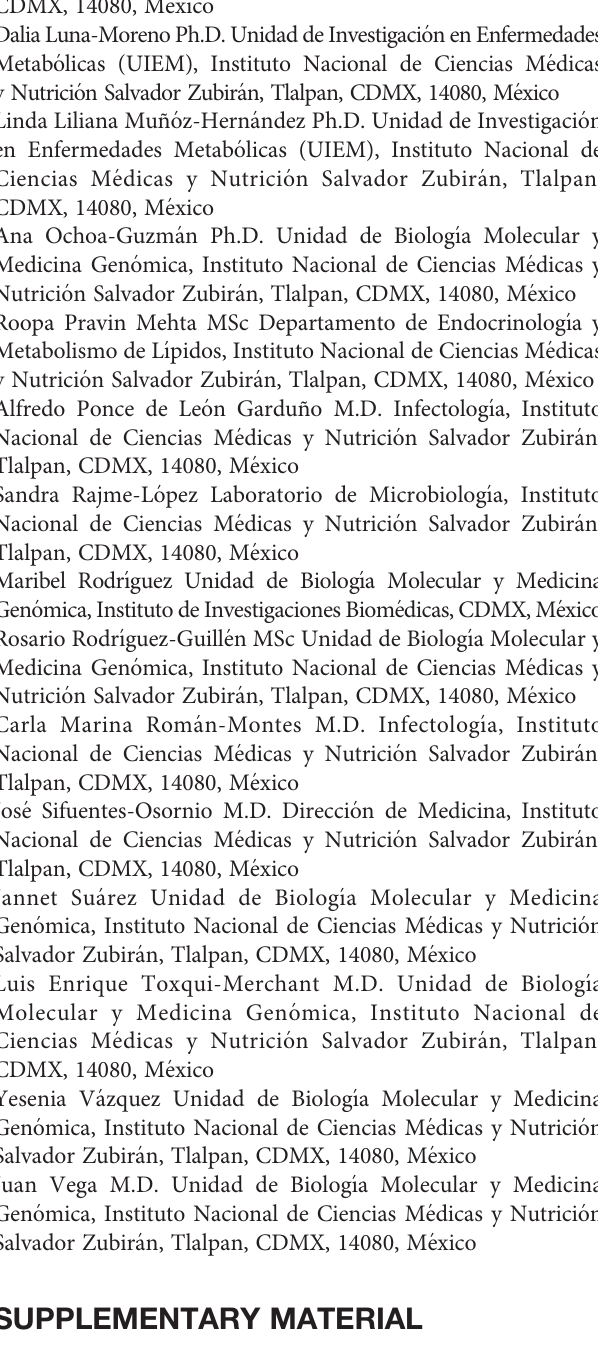
Supplementary Figure 1 | Two-dimensional score plots of selected principal components, according to disease